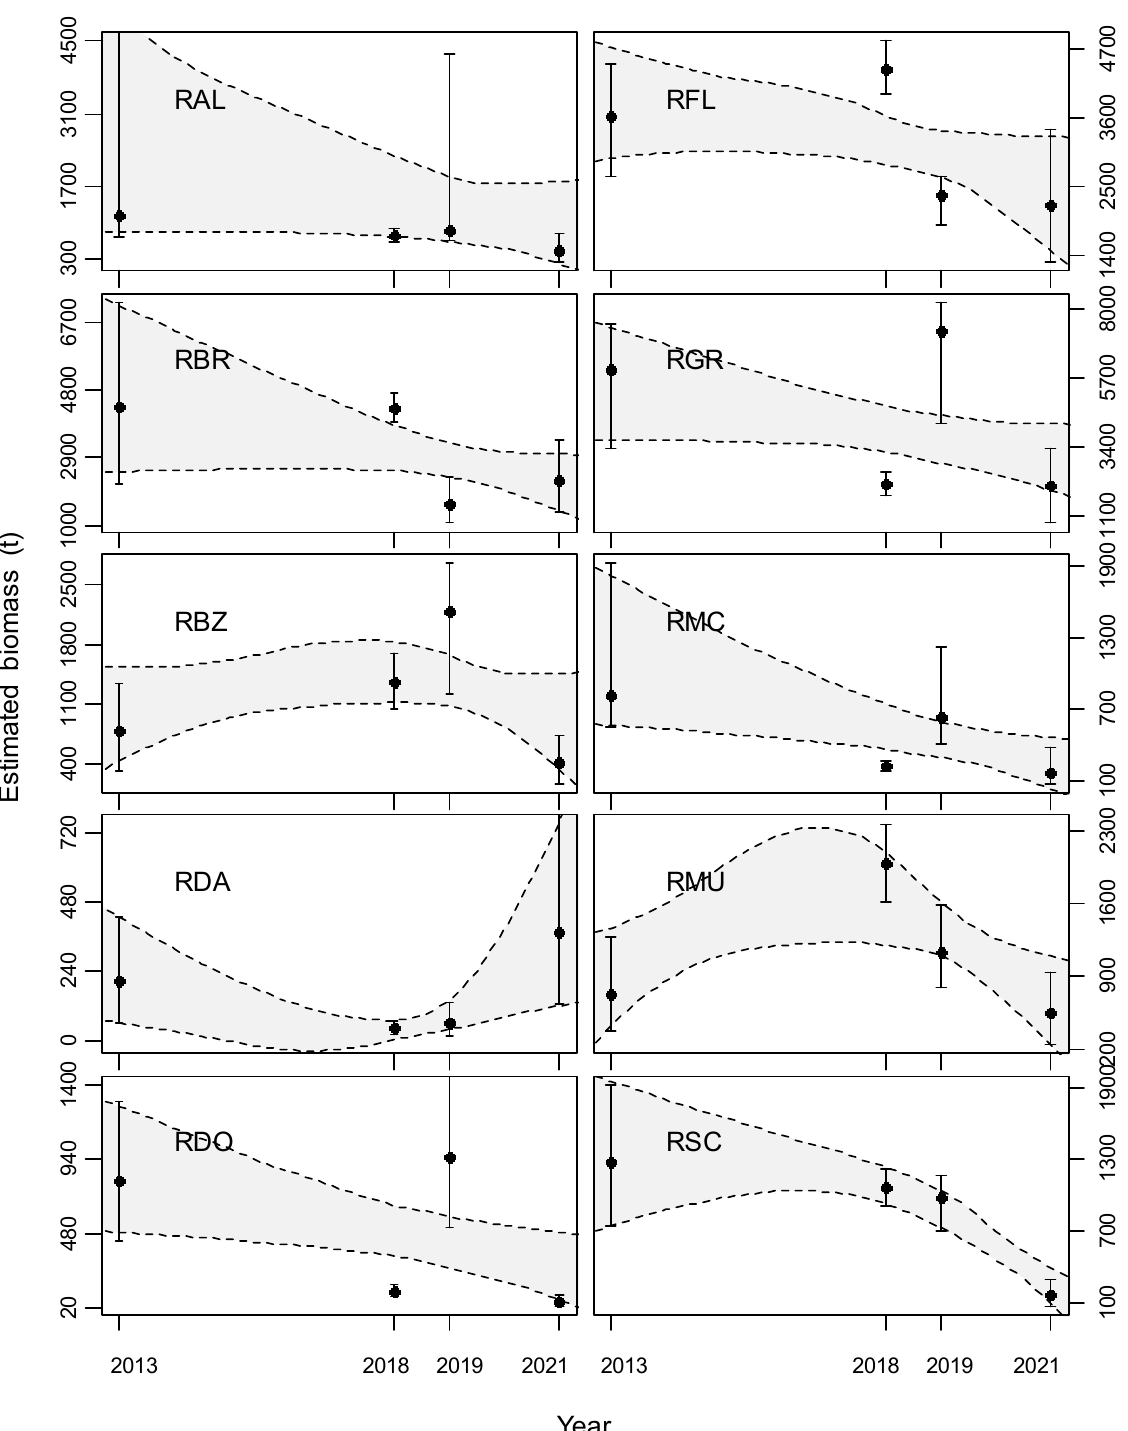
Figure 3. Biomass estimates of skate species in the North Skate box, from the four surveys in 2013 to 2021. Black symbols per year: point estimate ± 95% confidence intervals. Broken lines and grey under-shading: 95% confidence interval of the inter-annual GAM from randomized resampling. Falkland Islands species codes correspond to Table